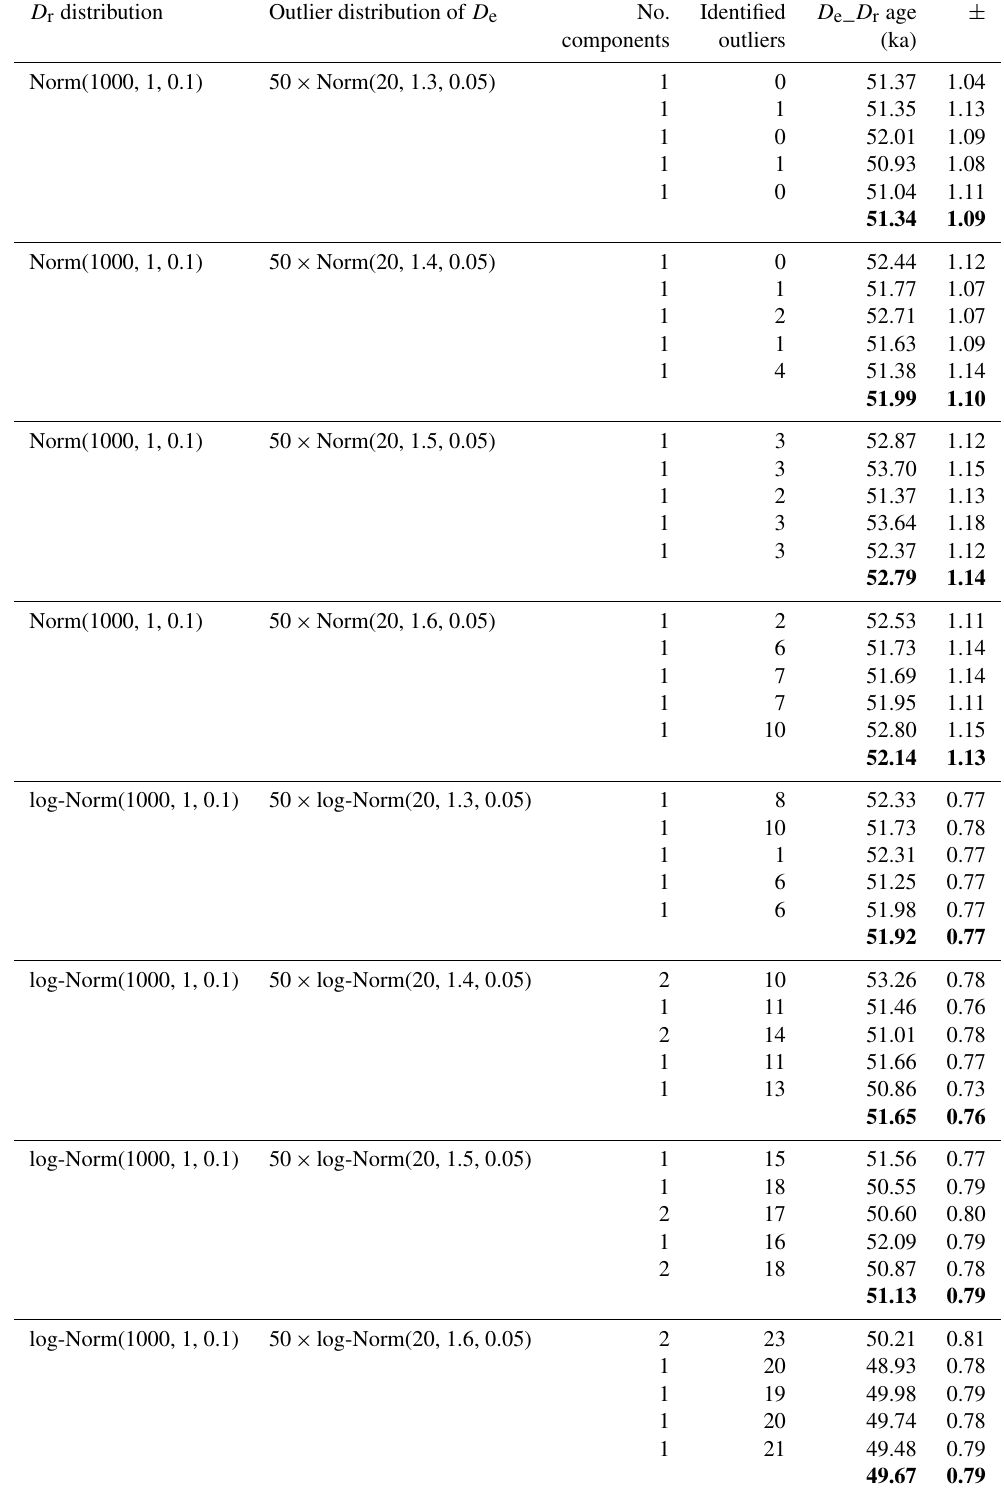
Table 2. Results of tests with 20 outliers added to the original D e distribution. Their values were determined following the function indicated in the second column. Notice that the ( m ) parameter of these functions varied from 1.3 to 1.6, leading to outlier values which, on average, increased, as is observable on the abanico plots (Fig. 7). Numbers in bold represent average values. D r